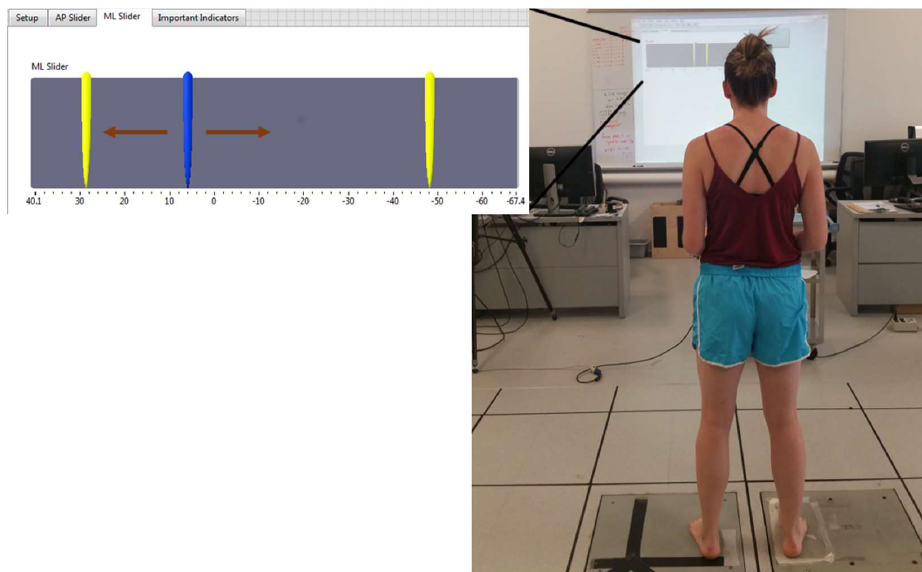
Figure 1. Experimental setup of data collection ( right ): example of visual feedback provided to study participants during the medial/lateral (ML) force control task ( left ): arrows indicate the direction the mobile cursor moves.